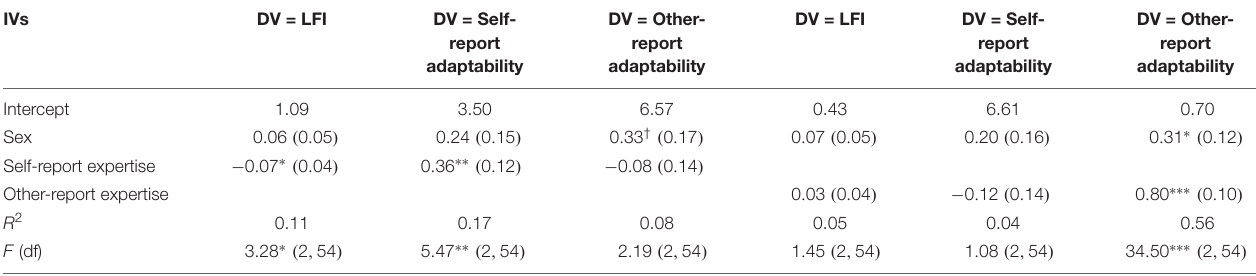
TABLE 2 | Regression results showing total effects of expertise on flexibility.